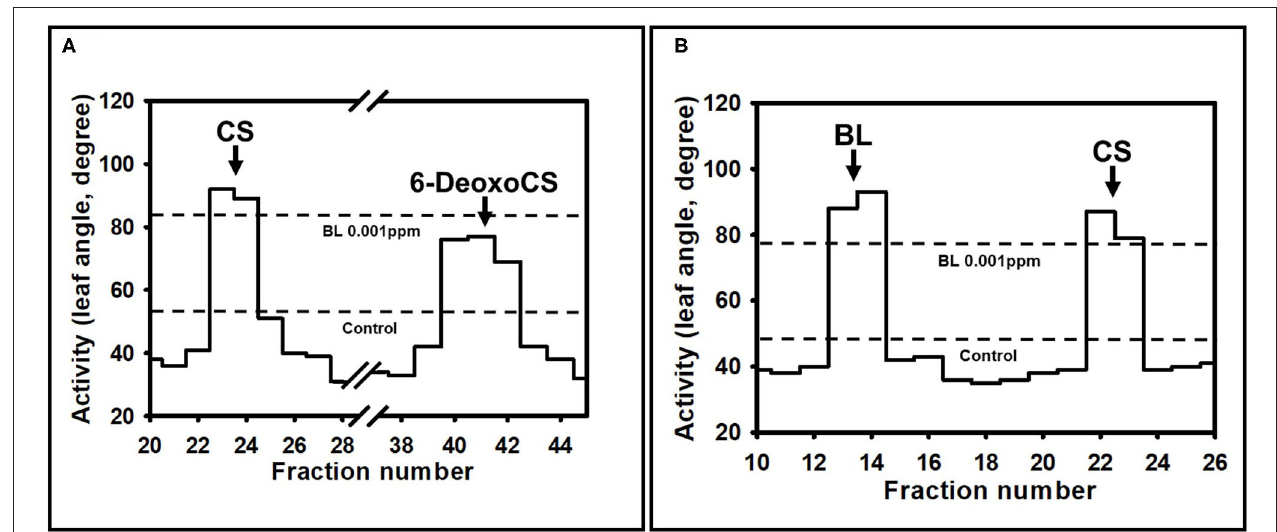
FIGURE 4 | Distribution of BR activity after a reversed phase HPLC. HPLC was carried out using a C 18 column (SenshuPak, 10 × 150mm) at flow 2.5mL min − 1 using MeCN-water gradients: 0–20min, 45% MeCN; 20–40min, 45–100% MeCN gradient; 40–70min, 100% MeCN. Fractions were collected every minute. The arrow indicates the elution points of authentic BRs. Activities shown were measured by rice lamina inclination assay. The average of 20 rice segments was calculated in every fraction. The dotted line represents the average biological activity after application of no BRs (Control) and BL 0.001 ppm. (A) The biological activity after HPLC when 6-deoxoCS was used as a substrate. (B) The biological activity after HPLC when CS was used as